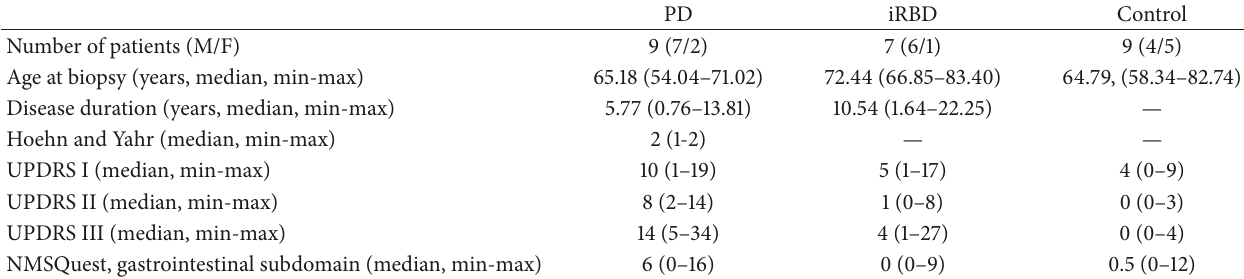
Table 1: Demographic and clinical data of the subjects included in the